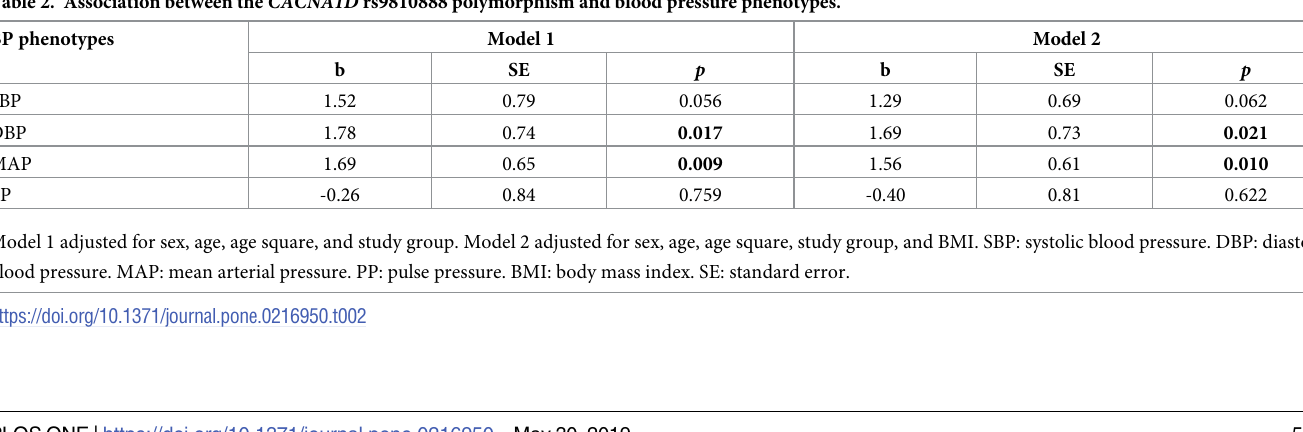
DHBP was also not significant ( p > 0.05, S2 Table ).